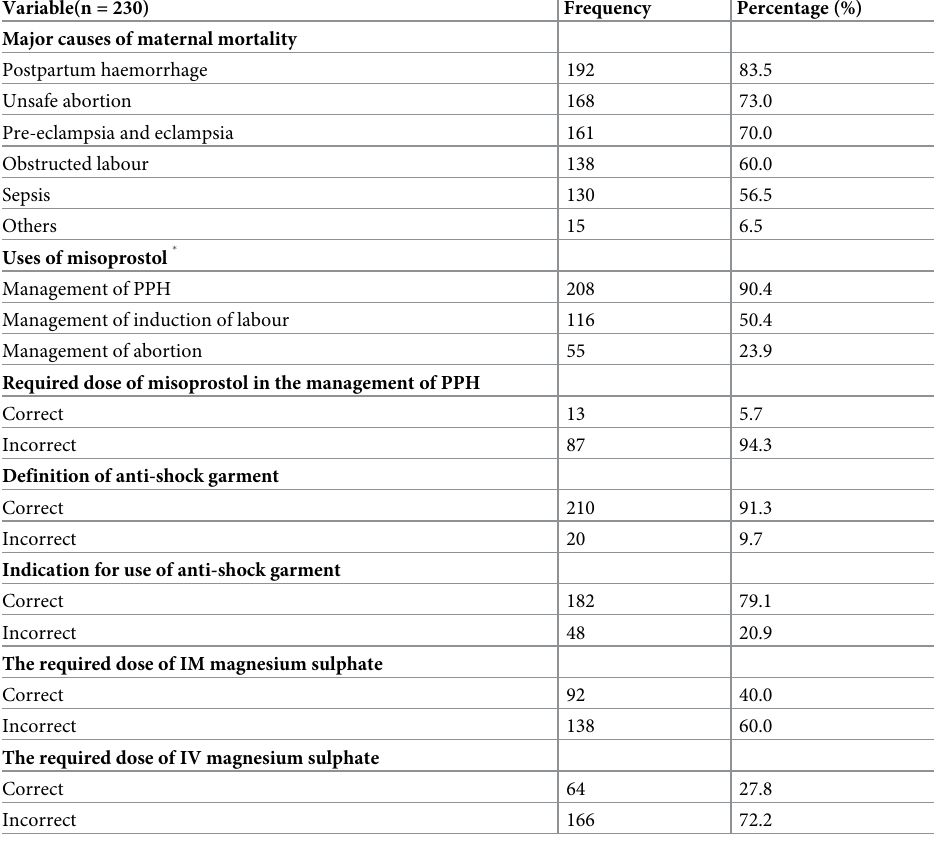
Table 2. Knowledge of major causes of maternal mortality in developing countires and the technologies for its reduction. Variable(n = 230)